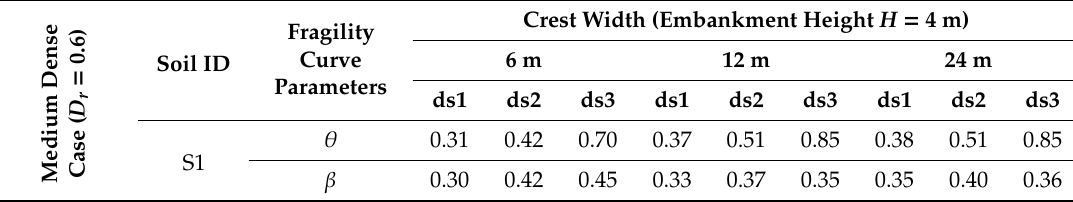
Table 7. FC parameters for di ff erent crest widths (medium dense soil, PGA, railway criteria).